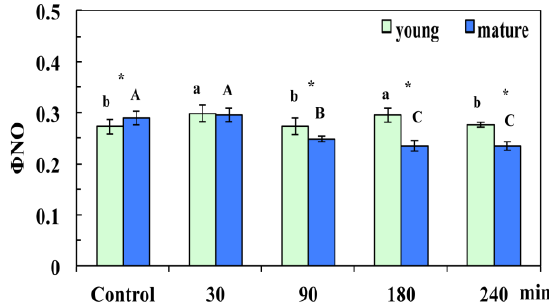
Figure 4. Changes in the quantum yield of non-regulated energy dissipation in PSII (Φ NO ) of Arabidopsis thaliana young and mature leaves measured (at 140 μmol photons m −2 s −1 ) 30 min, 90 min, 180 min, and 240 min after the foliar spay with 30 mg L −1 of CuZn NPs or distilled water (control). Error bars on columns are standard deviations based on four to five leaves from different plants. Columns with different letter (lower case for young leaves and capitals for mature) are statistically different ( p < 0.05). An asterisk (*) represents a significantly different mean of the same time treatment between young and mature leaves ( p < 0.05).